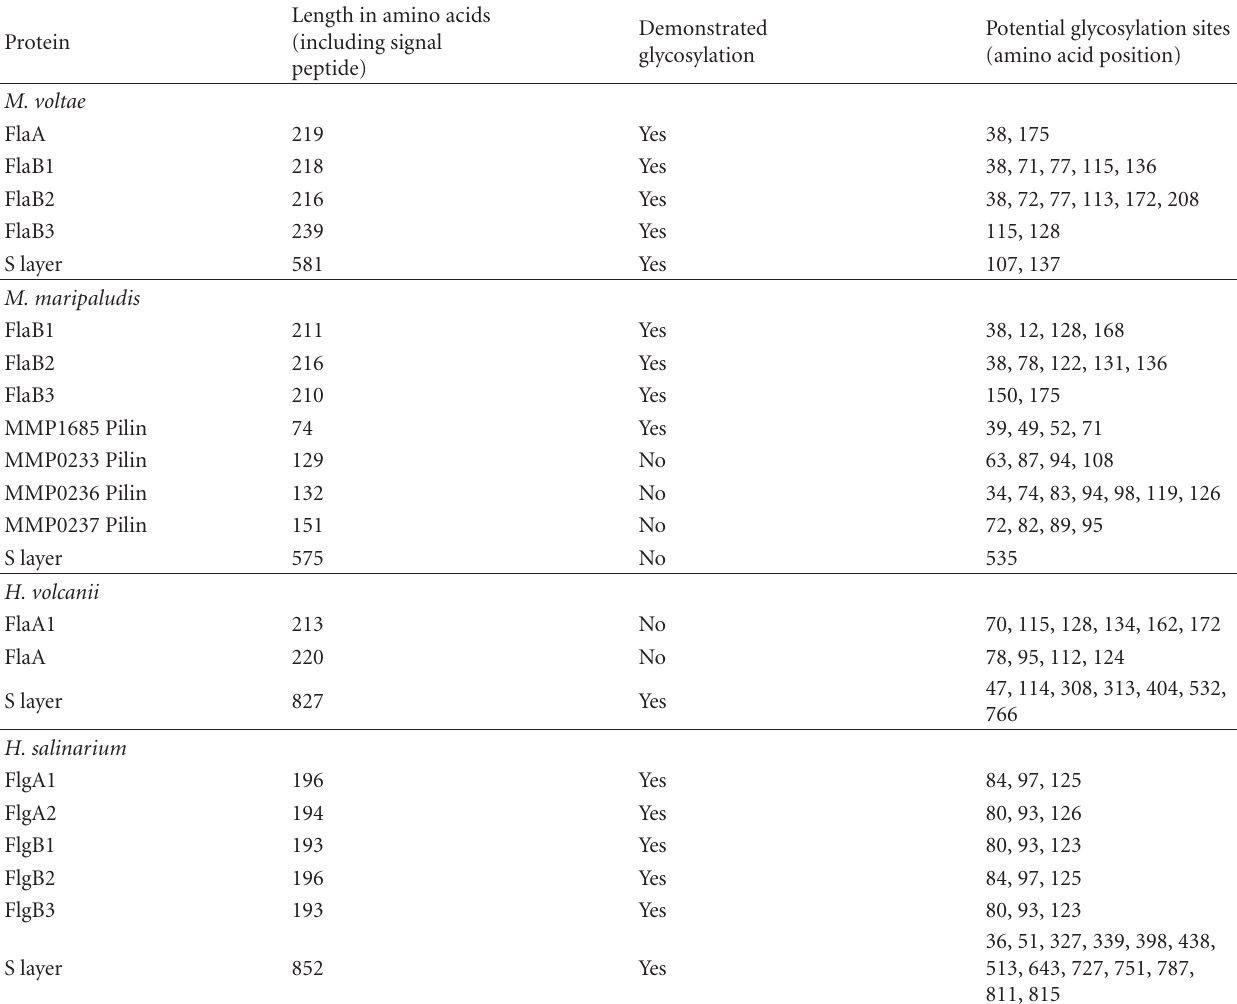
Table 2: Potential sites for N-glycosylation in selected archaeal